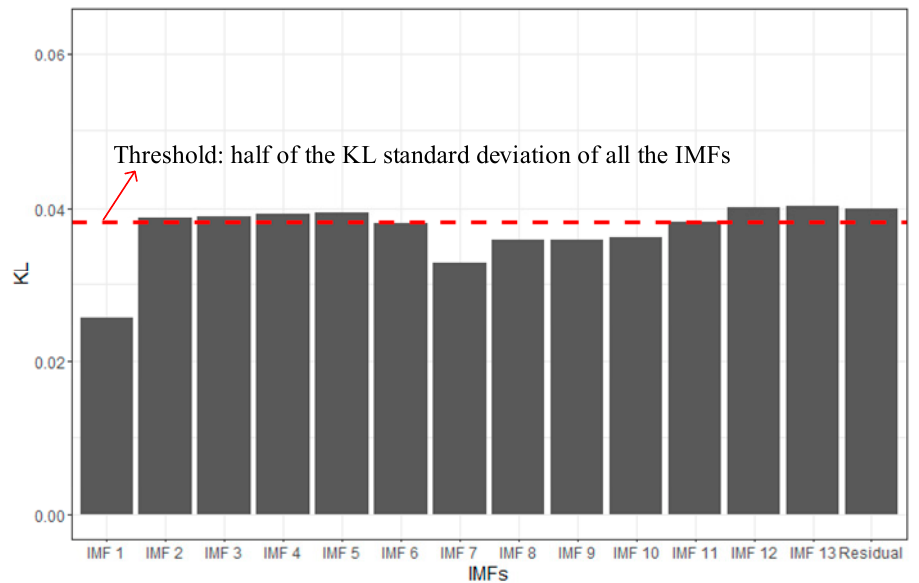
Figure 3. The relationship diagram between the intrinsic mode functions (IMFs) and KL.